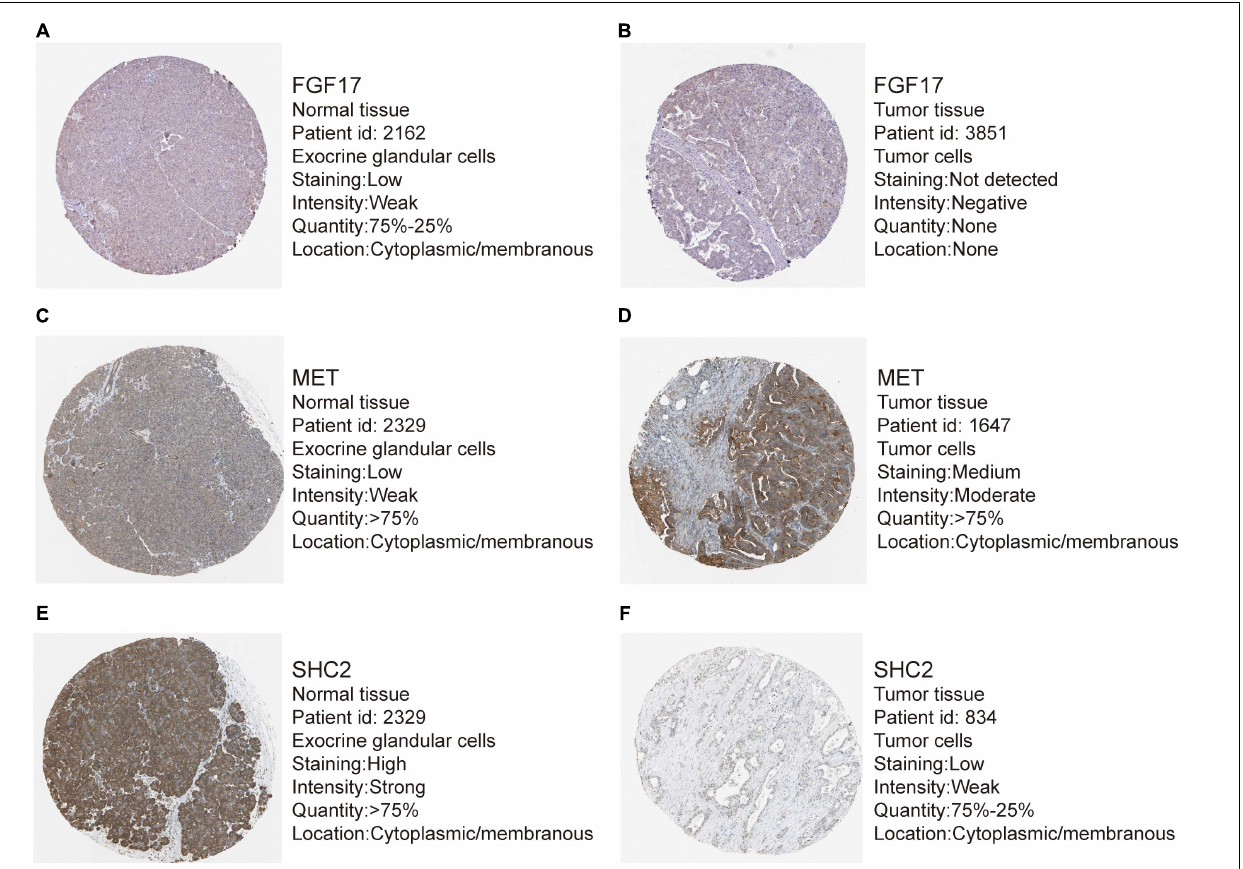
FIGURE 11 | Representative immunohistochemistry images for expression of FGF17, MET, and SHC2 in pancreatic cancer tissues and normal tissues were shown with the fraction of samples with antibody staining/protein expression level high, medium, low, or not detected. (A–B) Expression of FGF17 in PAAD tissues were lower than that in normal tissues. (C–D) Expression of MET in PAAD tissues were higher than that in normal tissues. (E–F) Expression of SHC2 in PAAD tissues were obviously lower than that in normal